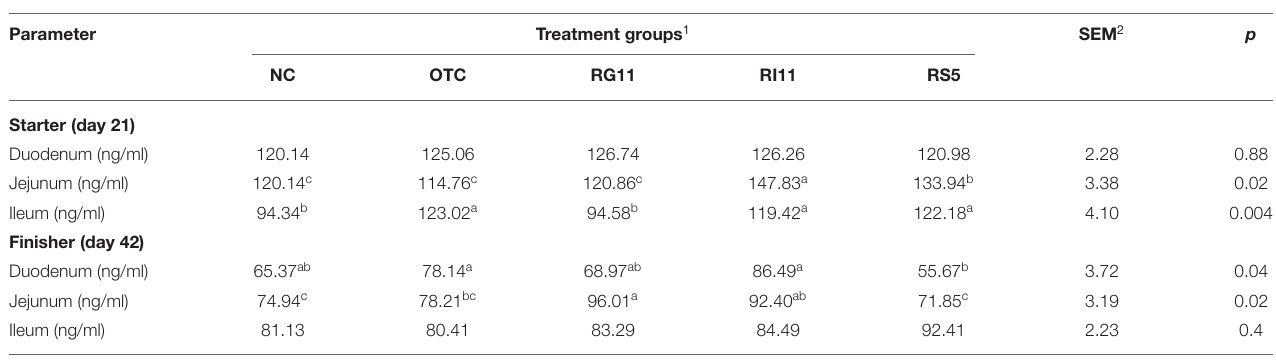
TABLE 6 | The GSH-Px concentration of chickens when fed with postbiotics. Parameter